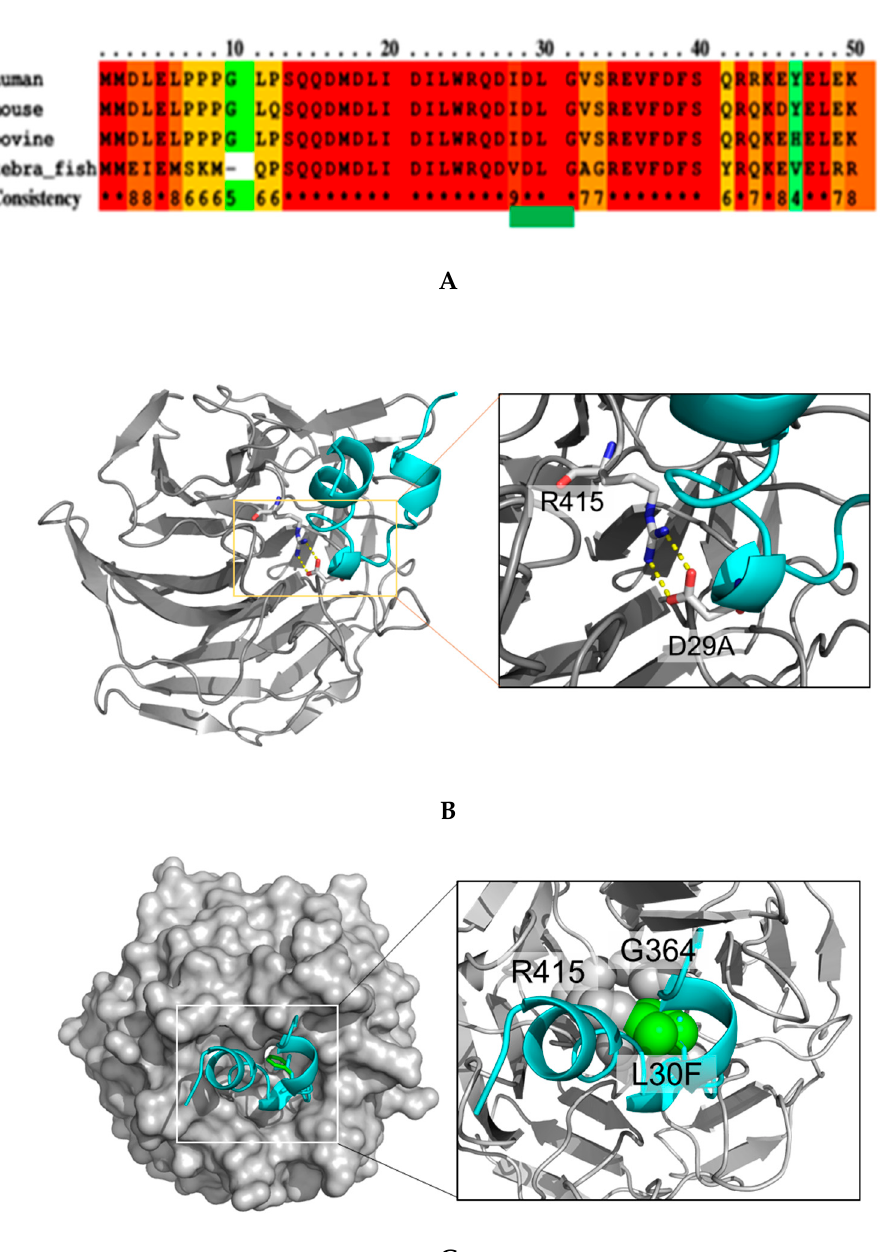
Figure 1. Evolutionally conserved NRF2 DLG domain and structural simulation of KEAP1/NRF2 MTs complex. ( A ) The alignment of the human, mouse, bovine, and zebrafish Nrf2 amino acid sequence. The red color box shows highly conserved (100%) elements among the species. DLG domain is indicated by green lines. ( B ) KEAP1 (gray) and NRF2 DLG (cyan) are shown by cartoon model. Hydrogen bonds between R415 of KEAP1 and D29 of NRF2 are shown by yellow dotted lines. ( C ) KEAP1 and NRF2 DLG are represented by surface (colored in gray) and cartoon (colored in cyan) models, respectively. In the enlarged view, G364 and R415 of KEAP1 are represented by gray spheres, whereas L30F of NRF2 is represented by a green sphere. All images were drawn using PyMOL.